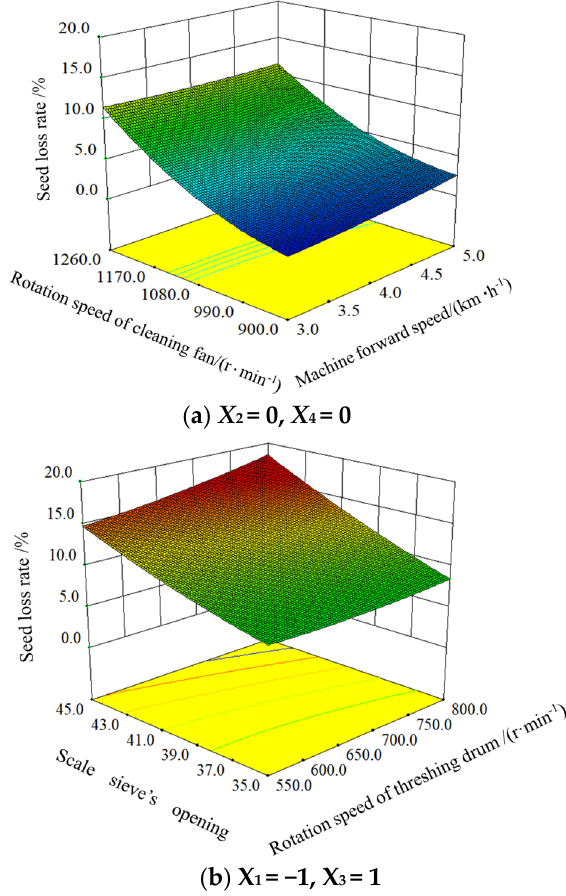
Figure 10. Response surfaces of seed loss rate.